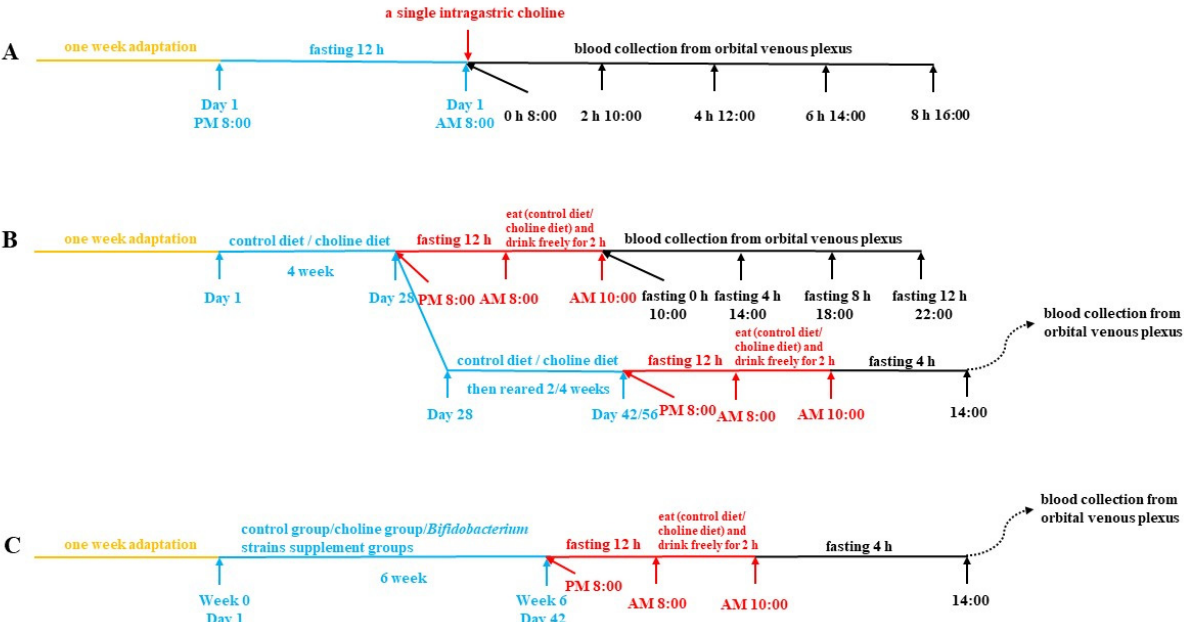
Figure 1. Timeline of experimental procedures used in this study: ( A ) collection of plasma after intragastric choline chloride administration, ( B ) collection of plasma after fasting, ( C ) collection of plasma after B. breve and B. longum supplementation.